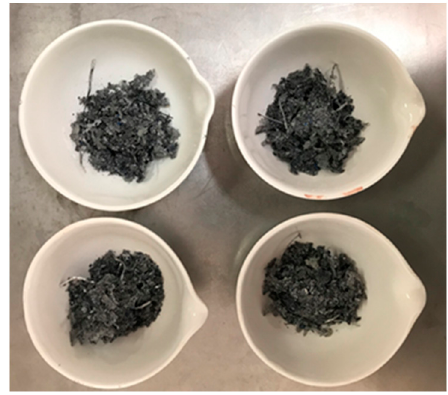
Figure 1. Samples after removing glass and backsheet.